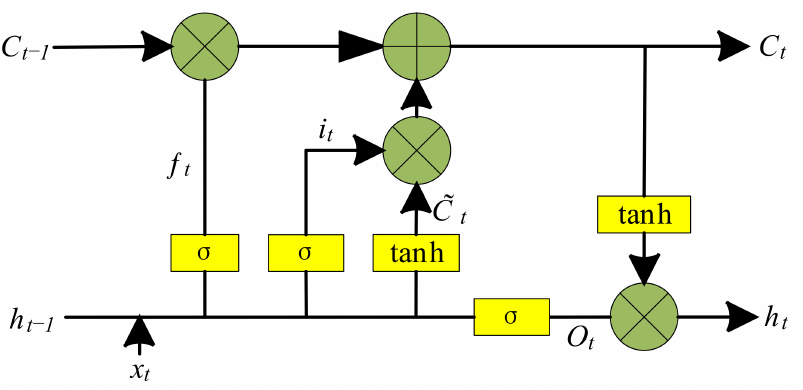
Figure 3. LSTM cell structure